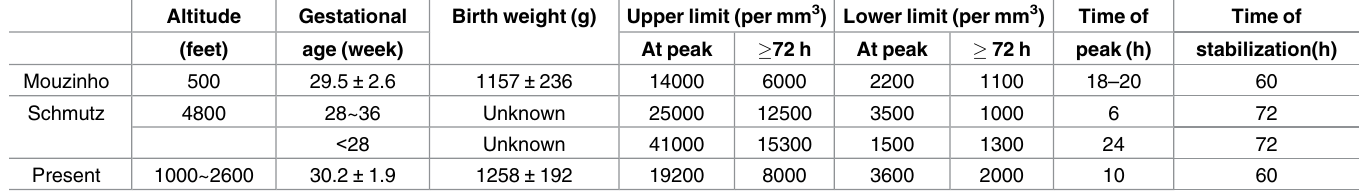
Table 4. Comparison of the present ATN referencerange with Mouzinho’s chart and Schmutz’s chart.